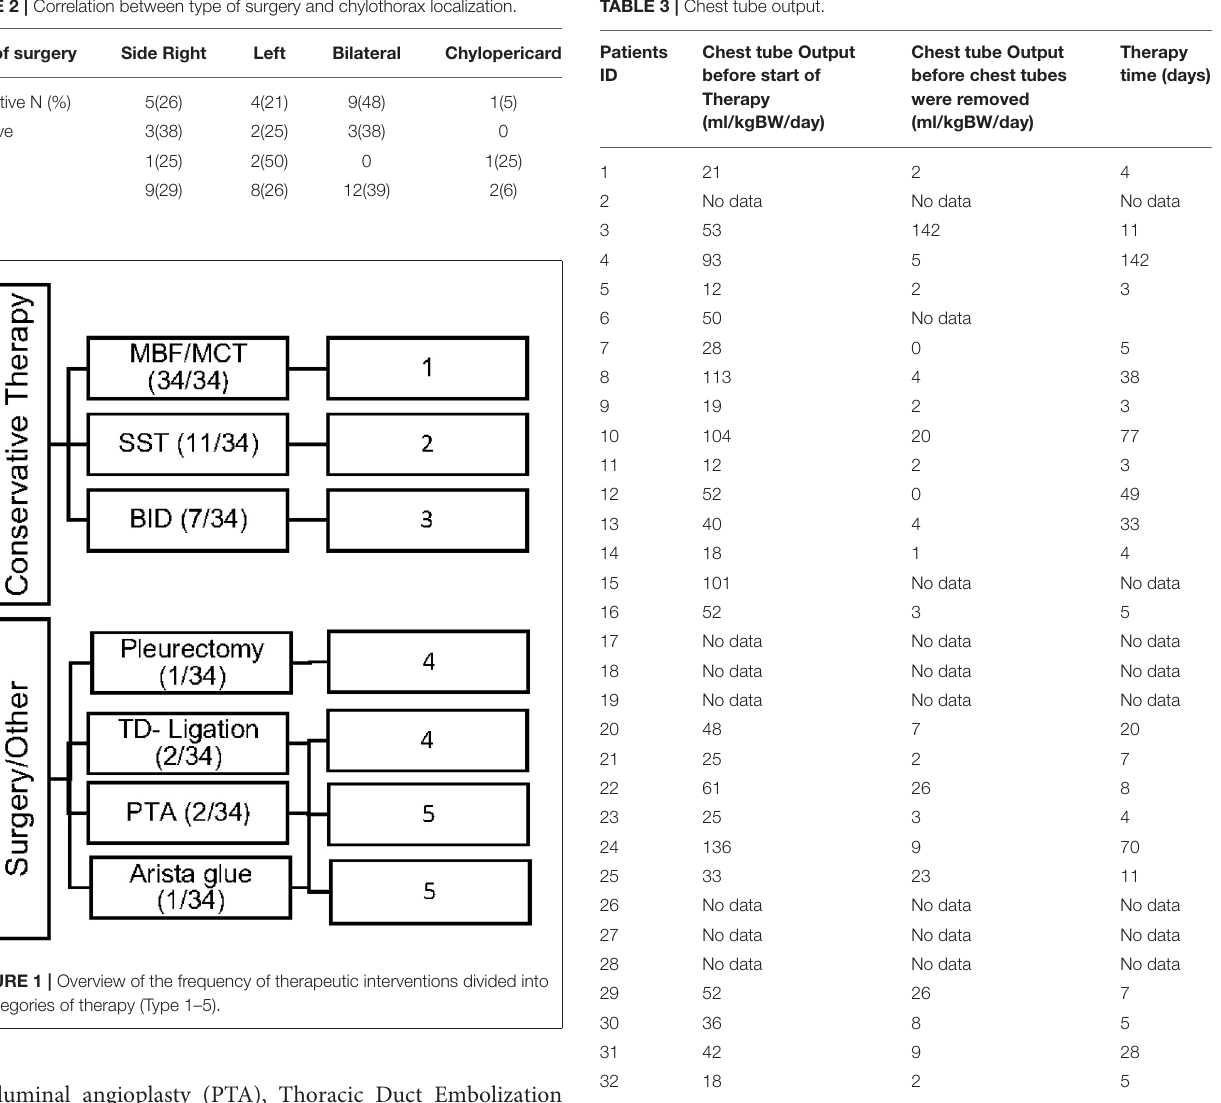
transluminal angioplasty (PTA), Thoracic Duct Embolization (TDE) (Yes/No).